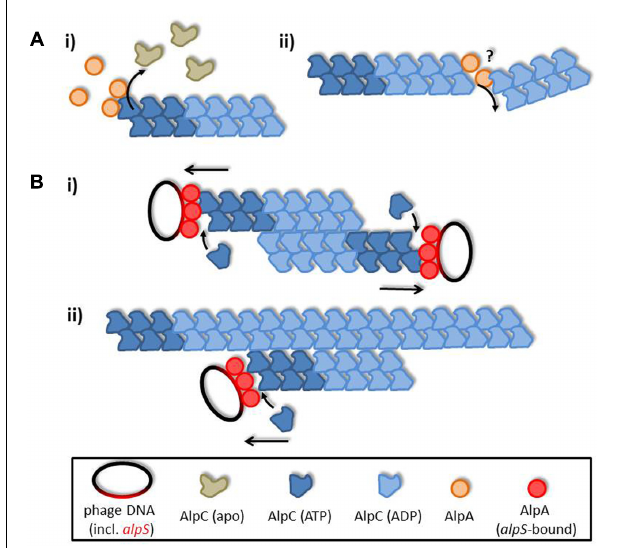
FIGURE 6 | AlpA promotes AlpC filament dynamics. (A) Unloaded adapter AlpA (orange) induces ATP hydrolysis in AlpC (blue), thereby leading to filament disassembly. The exact mode of actin of AlpA is unclear, yet, and could either be via depolymerizing AlpC filaments from the end (i) or by levering the filament, hence, inducing filament decay (ii). (B) Once loaded adapter proteins (AlpA– alpS nucleoprotein complex) interact with AlpC filaments these are stabilized and continue to grow, thereby segregating phage DNA. Interaction of AlpC filaments could be either (i) antiparallel, or (ii) AlpC filaments could track on pre-existing AlpC structures. In summary, action of AlpA leads to a simple search and capture mechanism ensuring efficient phage DNA